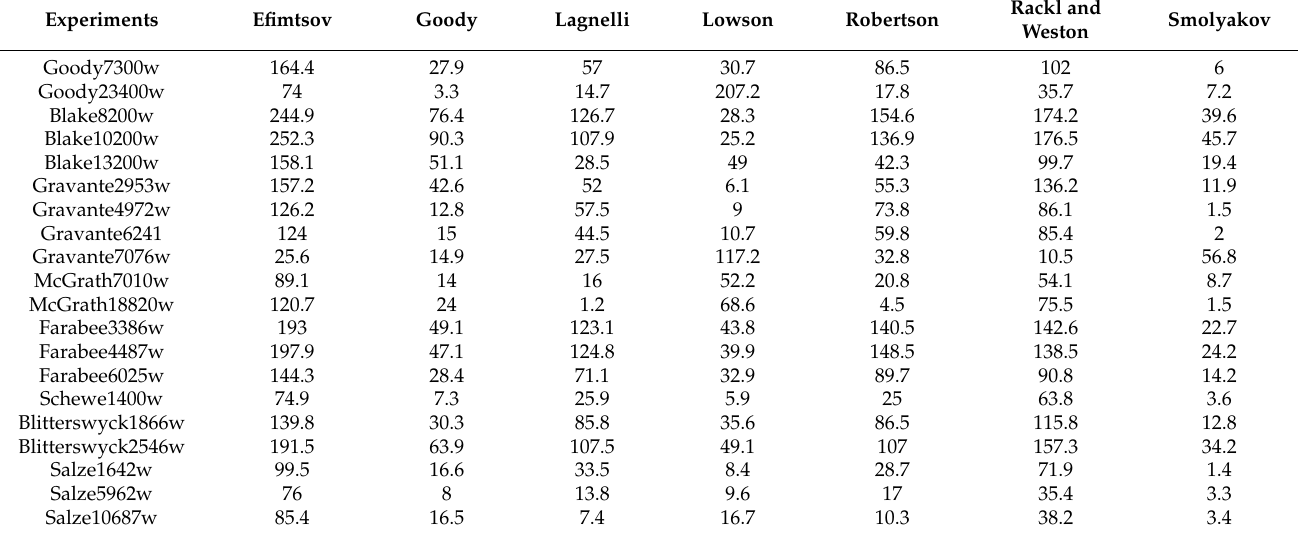
Table A7. Spectrum mean squared error for the high frequency